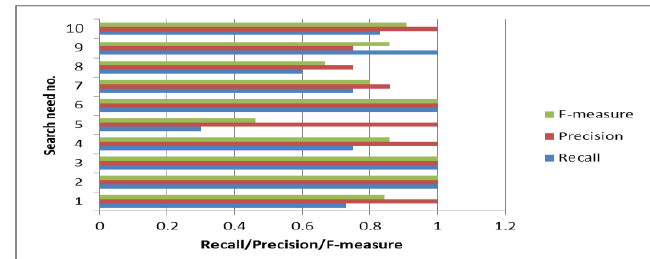
Fig. 14. Recall vs. precision scatter graph of Law-Torch.